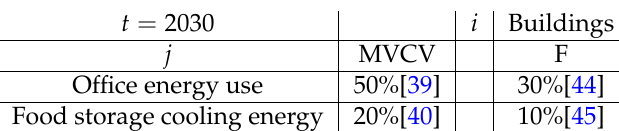
Table 12. Smart Building saving ICT solutions